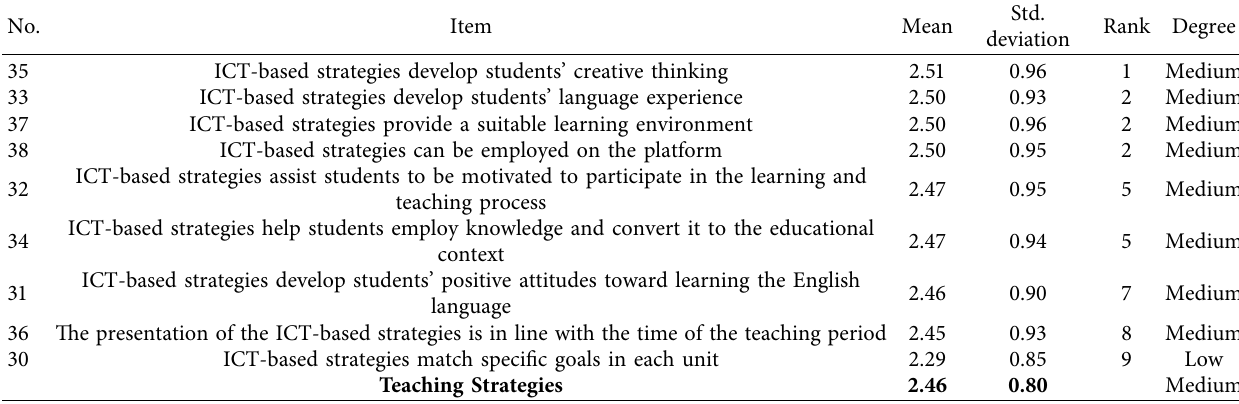
Table 5: Means, standard deviations, ranks, and degree of the study sample on the field of Teaching Strategies. No. Item